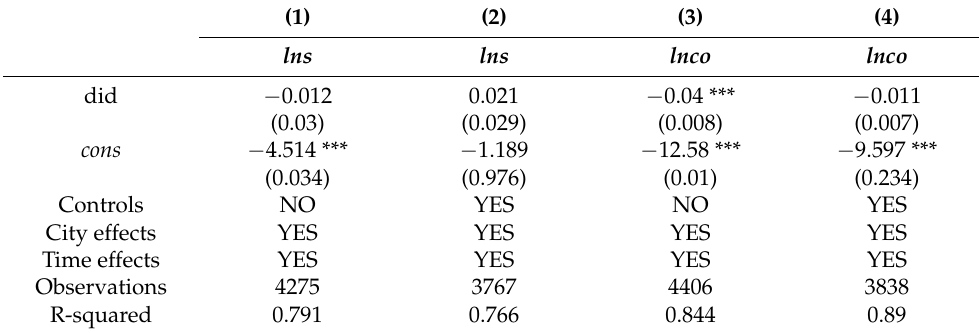
Table 4. Provincial DZs to national DZs (excluding EIPs).